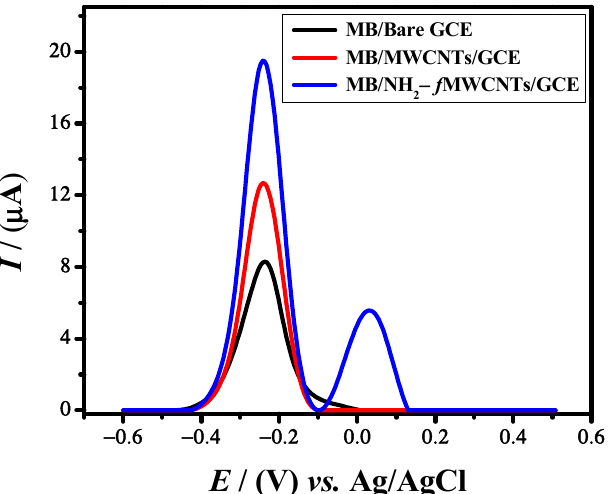
Figure 2. Comparative SWVs of 10 μ M MB at bare GCE, MWCNT’s/GCE, and NH 2 - f MWCNT’s/GCE in a potential window of − 0.6 to 0.5.